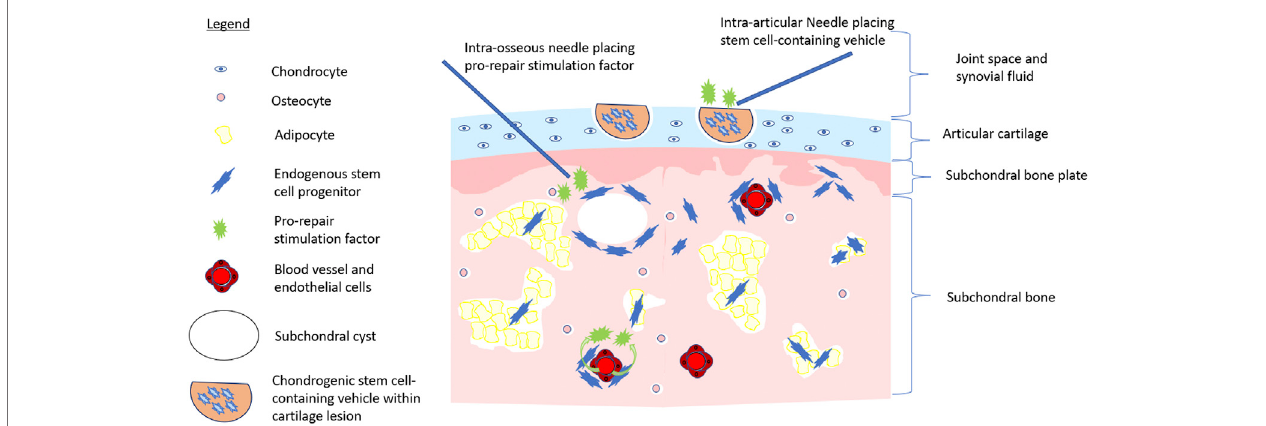
FIGURE 1 | Multistep approach to stem cell-initiated cartilage repair. Image depicts the application of chondrogenic stem cell-containing vehicle (e.g., hyaluronic acid injectate) to a cartilage lesion via intra-articular injection while pro-repair stimulation factors are applied to intra-articular space, via intra-osseous application, or systemically via the bloodstream to activate endogenous repair of the OA